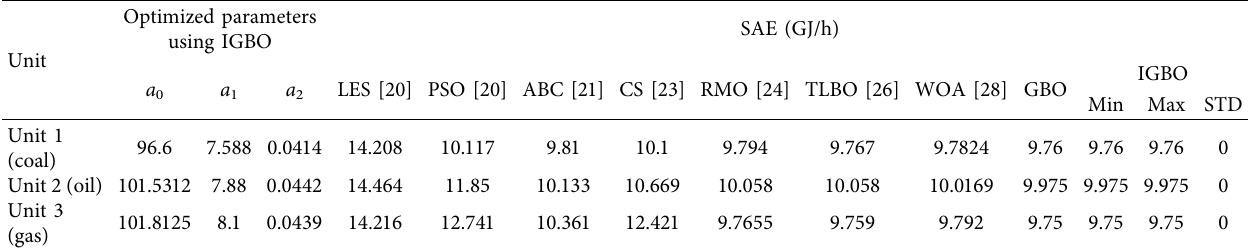
Table 7: Optimized parameters and SAE of model